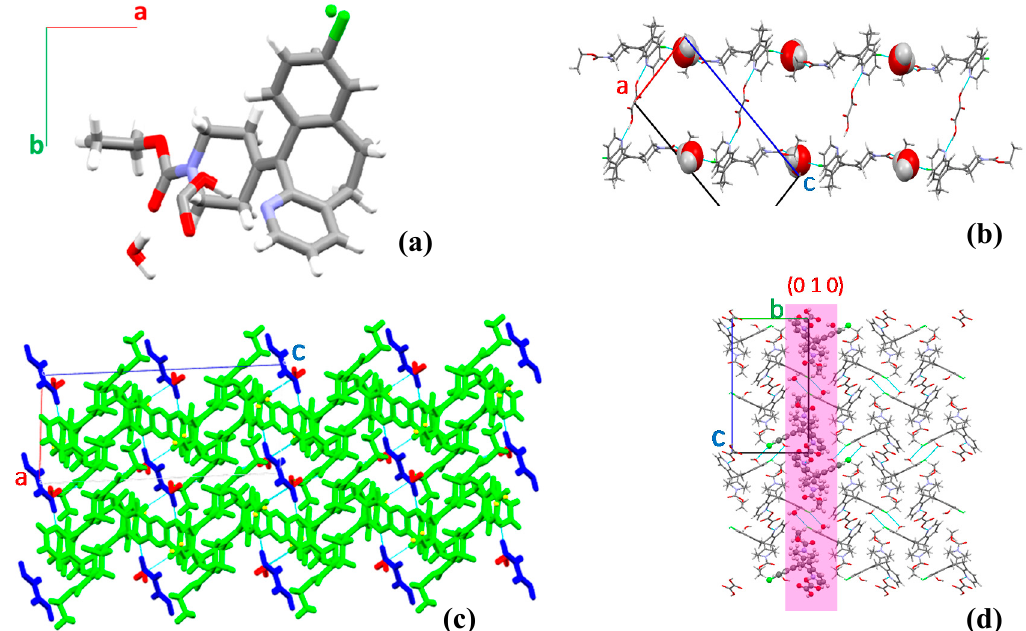
Figure 3. Crystal structure of Lor-Oxa hydrate: ( a ) asymmetric unit; ( b ) Lor-water chains bonded via Oxa; ( c ) structure of the (010) layer (Lor is green, Oxa is blue, and water is red), and ( d ) viewed into a-axis with a (010) layer is highlighted in pink.